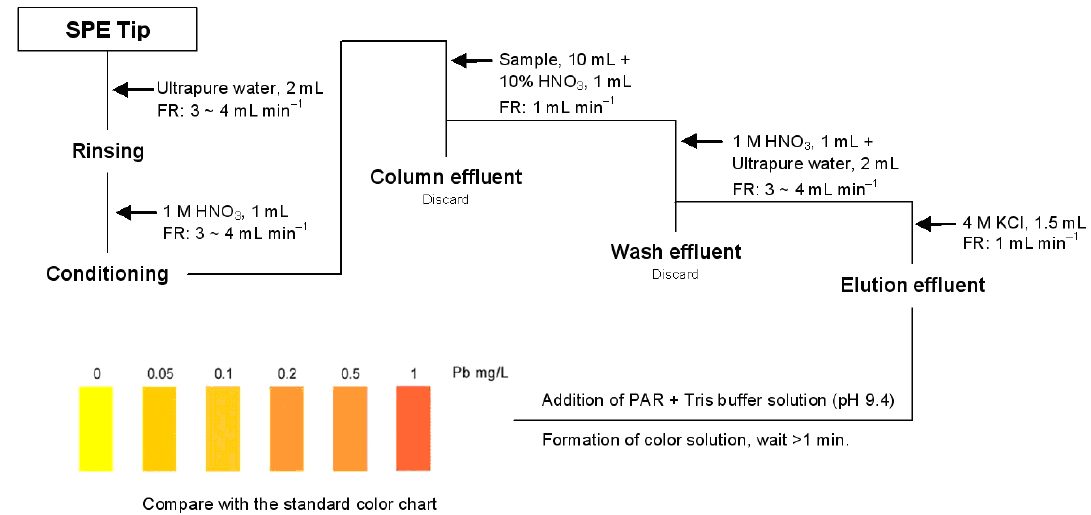
Figure 3. Scheme for on-site semi-quantitative determination of